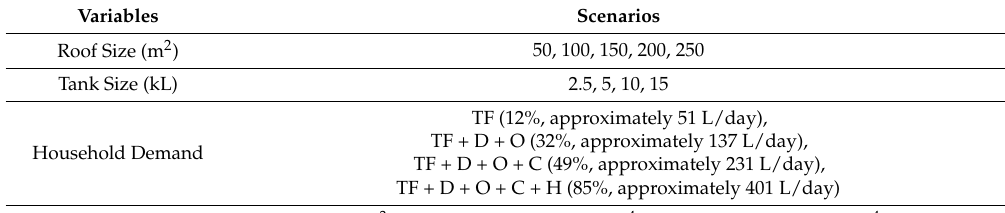
Table 2. Simulation Scenarios. Where TF is toilet flushing, D is dishwasher, O is outdoor usage (e.g., garden irrigation), C is clothes washing, and H is hot